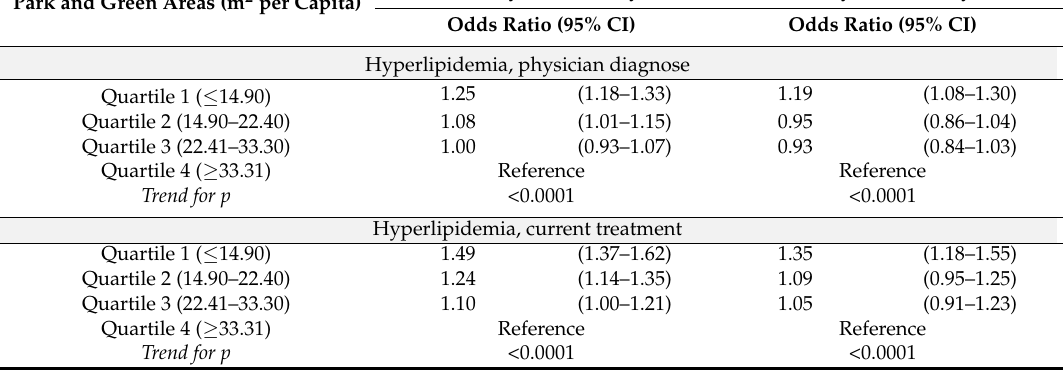
Table 3. Odds ratio (95% CI) of hyperlipidemia by the quartiles of parks and green areas (Moderate physical activity NO vs.